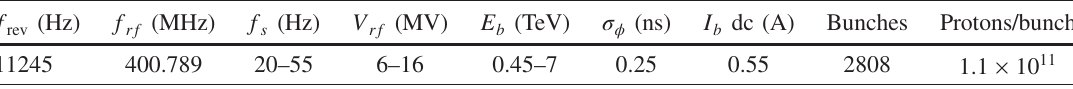
TABLE I. LHC design rf